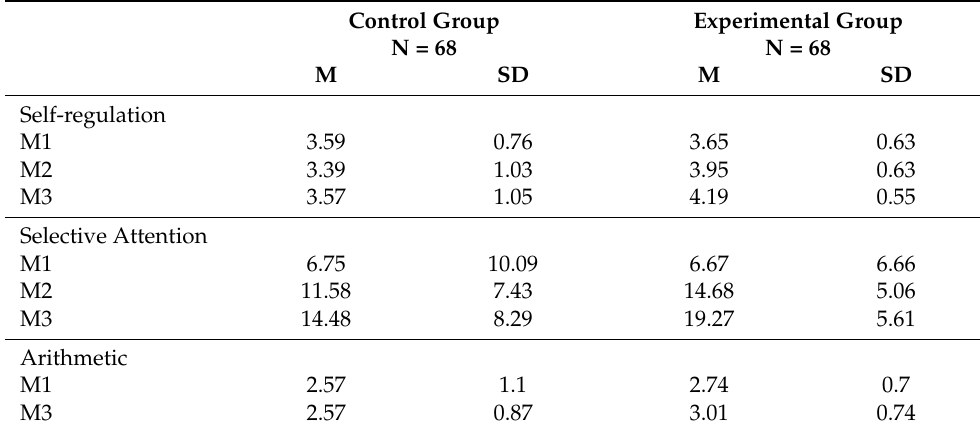
Table 2. Descriptive Statistics for SR, SA and Arithmetic dependent variables.